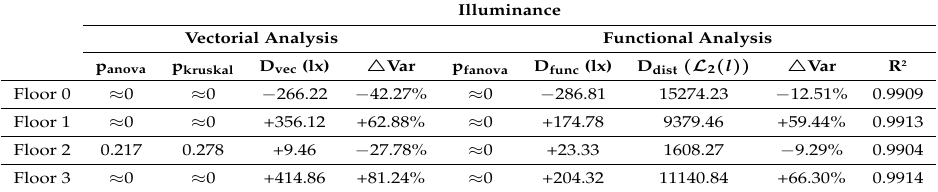
Table 3. Numerical results on each floor for illuminance. The vectorial results are presented with D vec measuring the difference between medians. The functional results, accompanied with the average minute difference (D func ), the L 2 ( l ) distance between the mean functions (D dist ) and the smoothing adjustment (R 2 ), are also presented. For both analyses, the change in the variability of the data is displayed ( (cid:52) Var). Lastly, the p -values for the tests, both vectorial and functional, are displayed in this